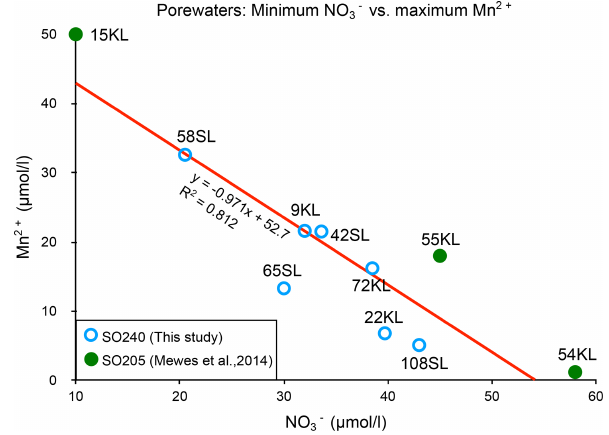
Figure 6. Relationship between maximum Mn 2 + and minimum NO 3 − concentrations for the cores with a suboxic